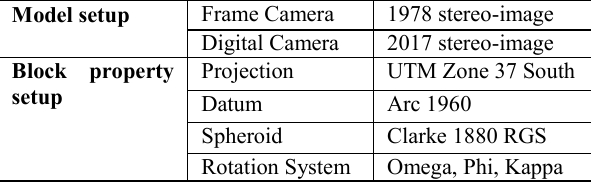
Table 1: Summary of model and block properties set up